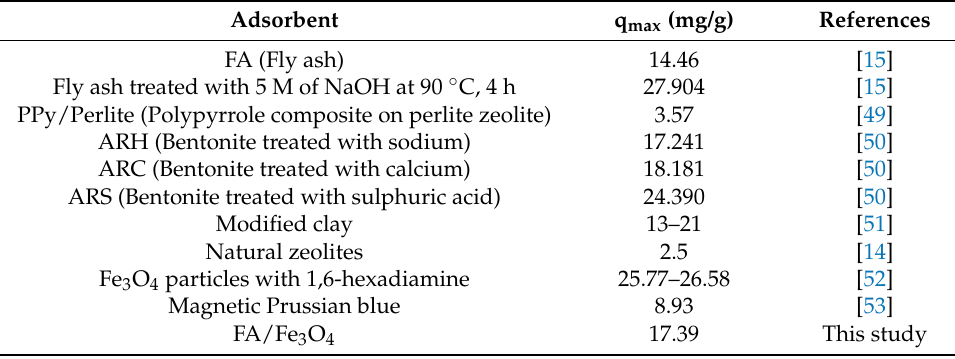
Table 5. Maximum Cu (II) adsorption capacities (q max